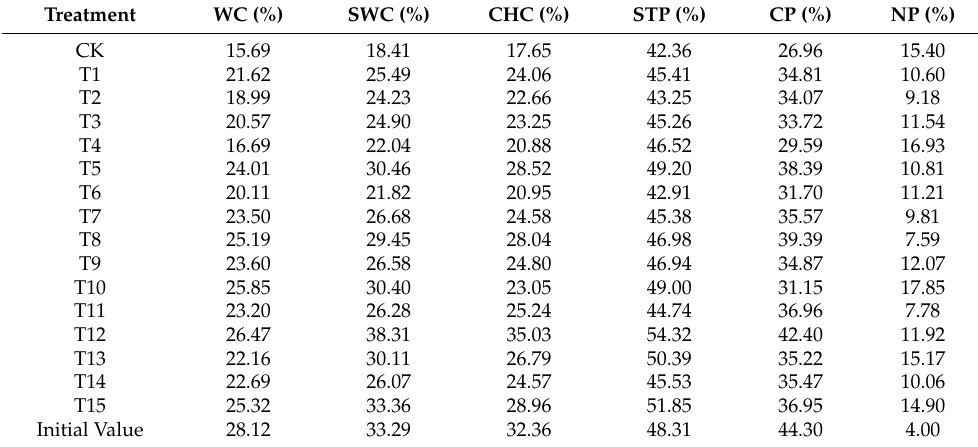
Table 2. The average value of soil water content (WC), soil saturated water content (SWC), capillary water holding capacity (CHC), soil total porosity (STP), capillary porosity (CP) and noncapillary porosity (NP) measured in different treatment plots compared with the initial values of soil properties.